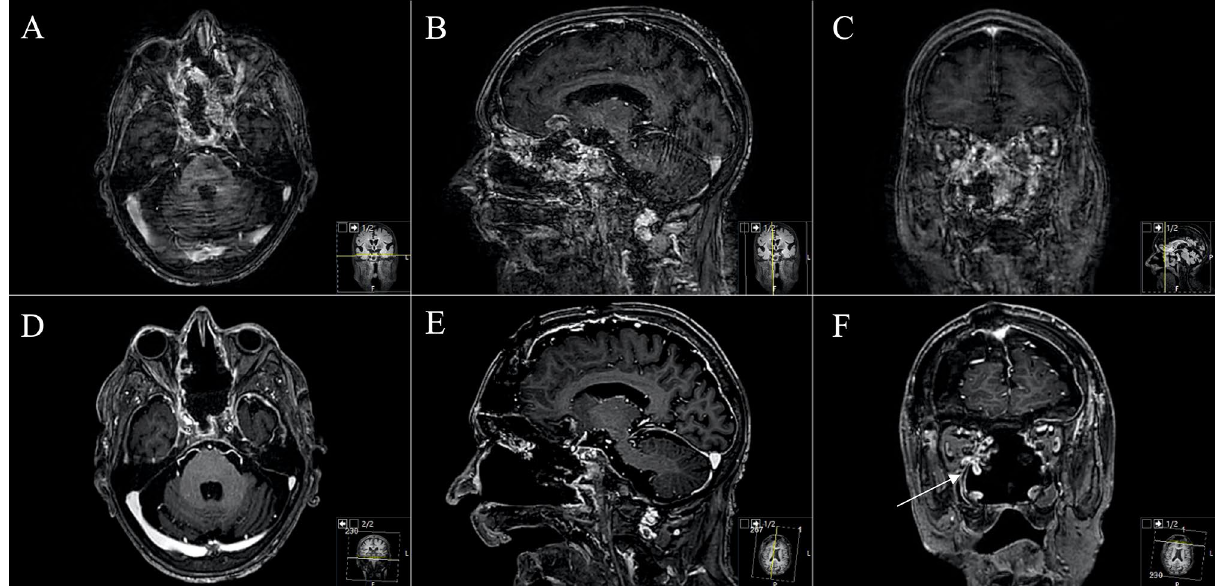
Figure 4. Exemplary case 4: a 78-year-old male patient with bilateral amaurosis, anosmia and psychomotoric disorders. Known sinusinal intestinal adenocarcinoma after endonasal biopsy. Radiotherapy was already carried out. Transnasal microscopic tumor debulking was performed a priori. ( A – C ) Preoperative T1-weighted gadolinium-enhanced MR imaging showing the huge infiltrating transbasal tumor with right orbital destruction and maxillary sinus affection. Reconstruction was performed with split-bone graft, galea-periosteum flap and collagen-based dura graft. No postoperative CSF leak occurred. ( D – F ) Postoperative MR control showing subtotal resection. F Small tumor remnant in the right periorbital.